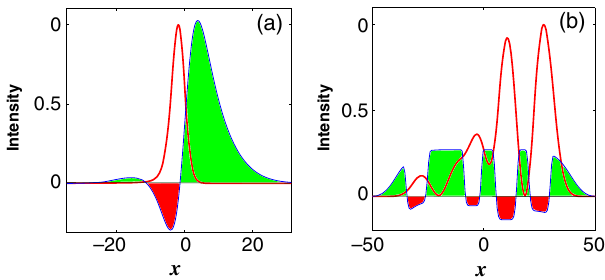
FIG. 5. Intensity plots (red lines) of the optimal initial con- ditions that lead to maximum transient growth for (a) a single waveguide and (b) a multimode waveguide with random dis- tribution of its imaginary part. In both plots, the blue lines represent the imaginary part of the non-normal optical